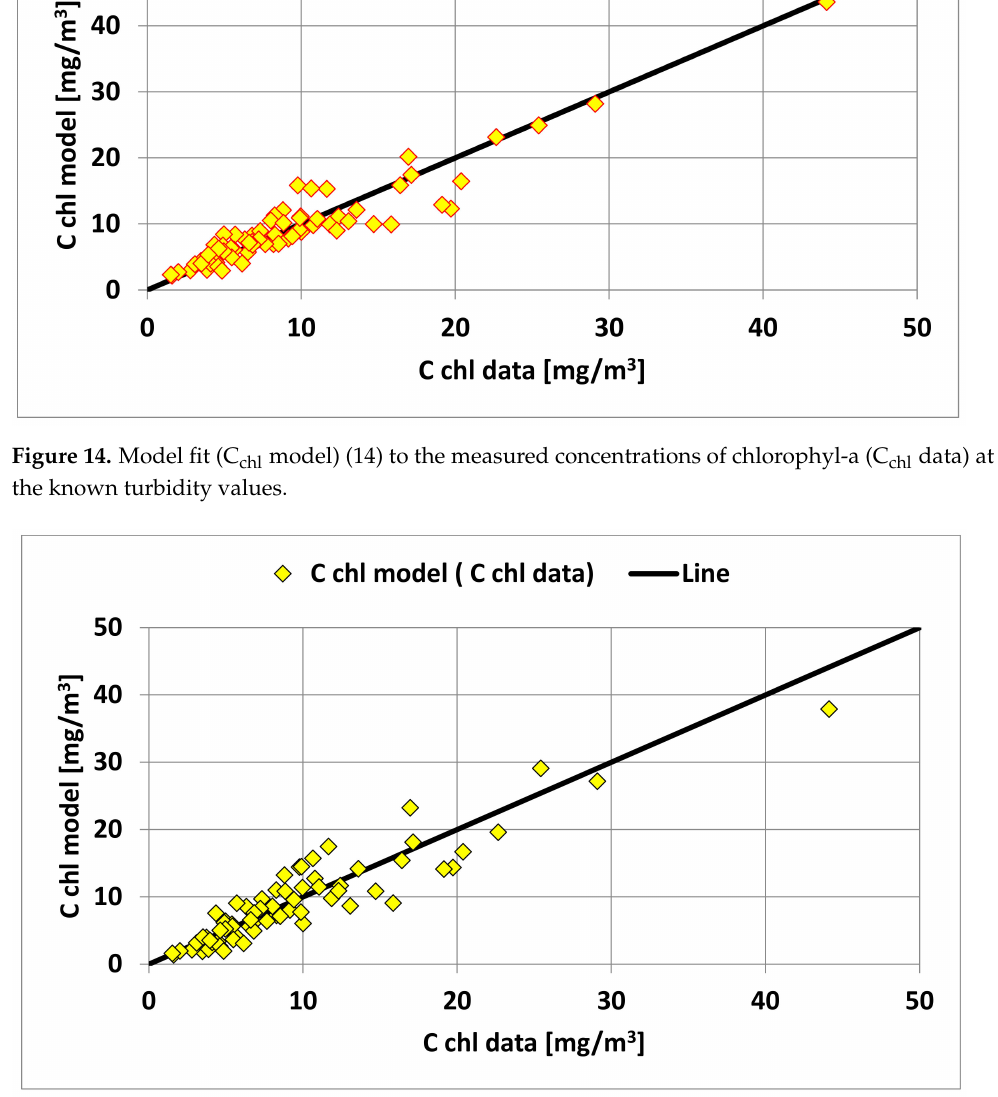
Figure 15. Model fit (C chl model) (14) to the measured concentrations of chlorophyl-a (C chl data) for turbidity model